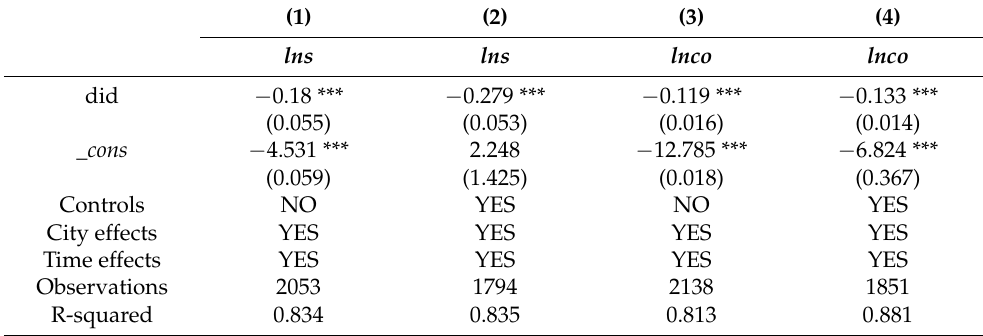
Table 5. National DZs to